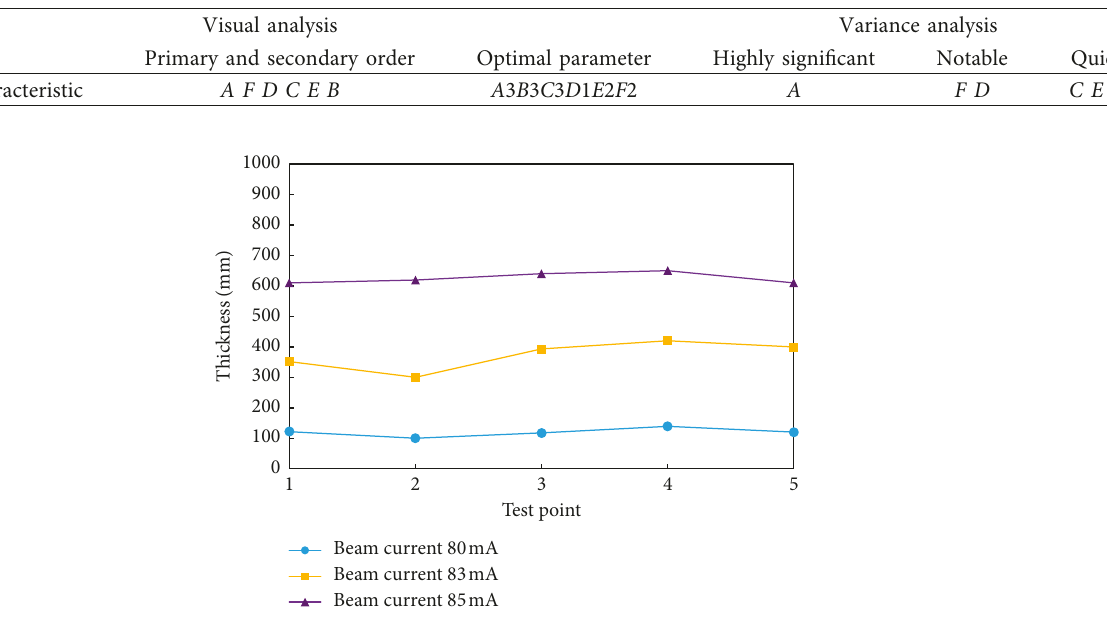
Table 7: Test results.